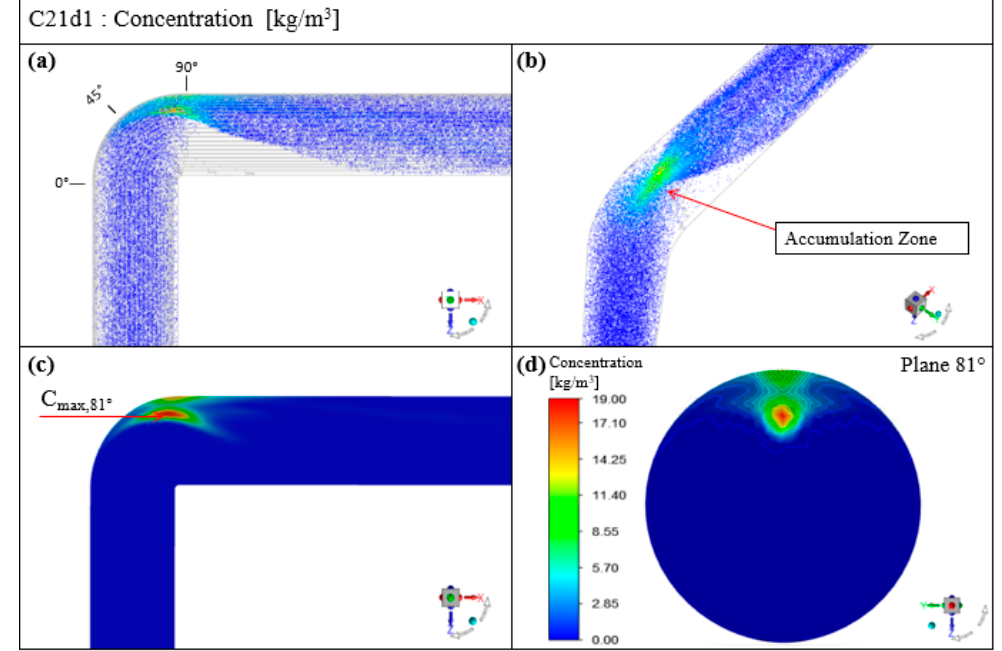
Figure A4. Results of particle concentration. Case C21d1. ( a ) Instant positioning of the X-Z plane particles ( b ) Instant positioning of the particles in 3D view ( c ) Concentration contour in the X-Z plane of the mid-section of the pipe ( d ) Concentration contour in the Z-Y plane of the maximum concentration cross section. Snapshots are taken for a statistically steady flow.